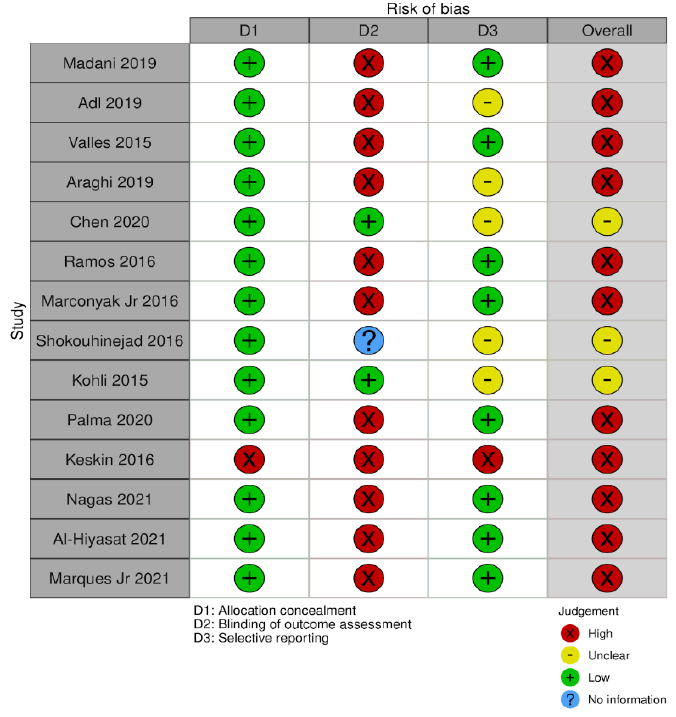
Figure 2. Risk of bias summary according to the Cochrane Handbook for Systematic Reviews of Interventions.